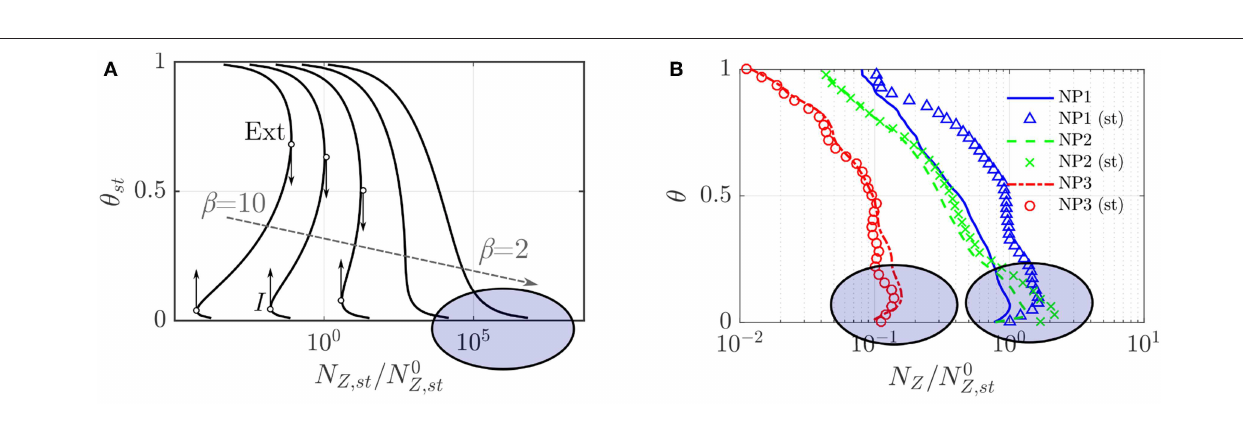
FIGURE 5 | Variation of normalized temperature at stoichiometry location with the corresponding mixture fraction dissipation rate in (A) conventional non-premixed and (B) turbulent MILD non-premixed combustion. The variation of h N Z | θ i with θ constructed using the entire DNS sample is also shown in (B) using lines.